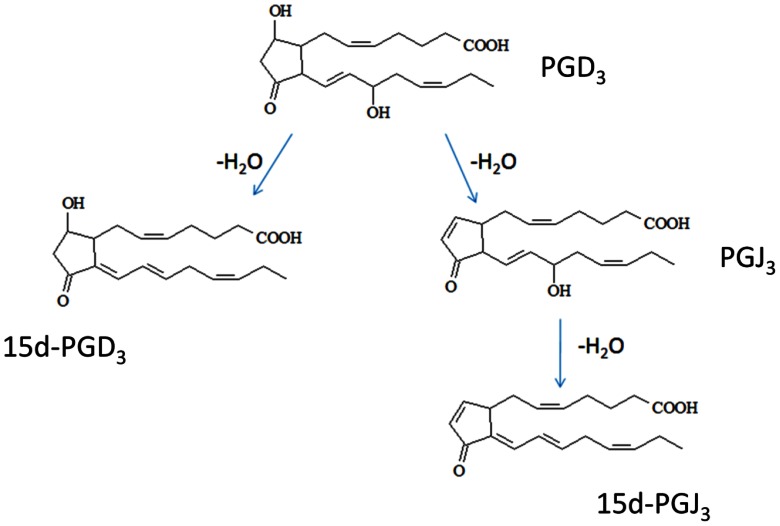
Proposed pathway for PGD3 metabolism(adapted from Ref Shibata et al., 2002 for PGD2).